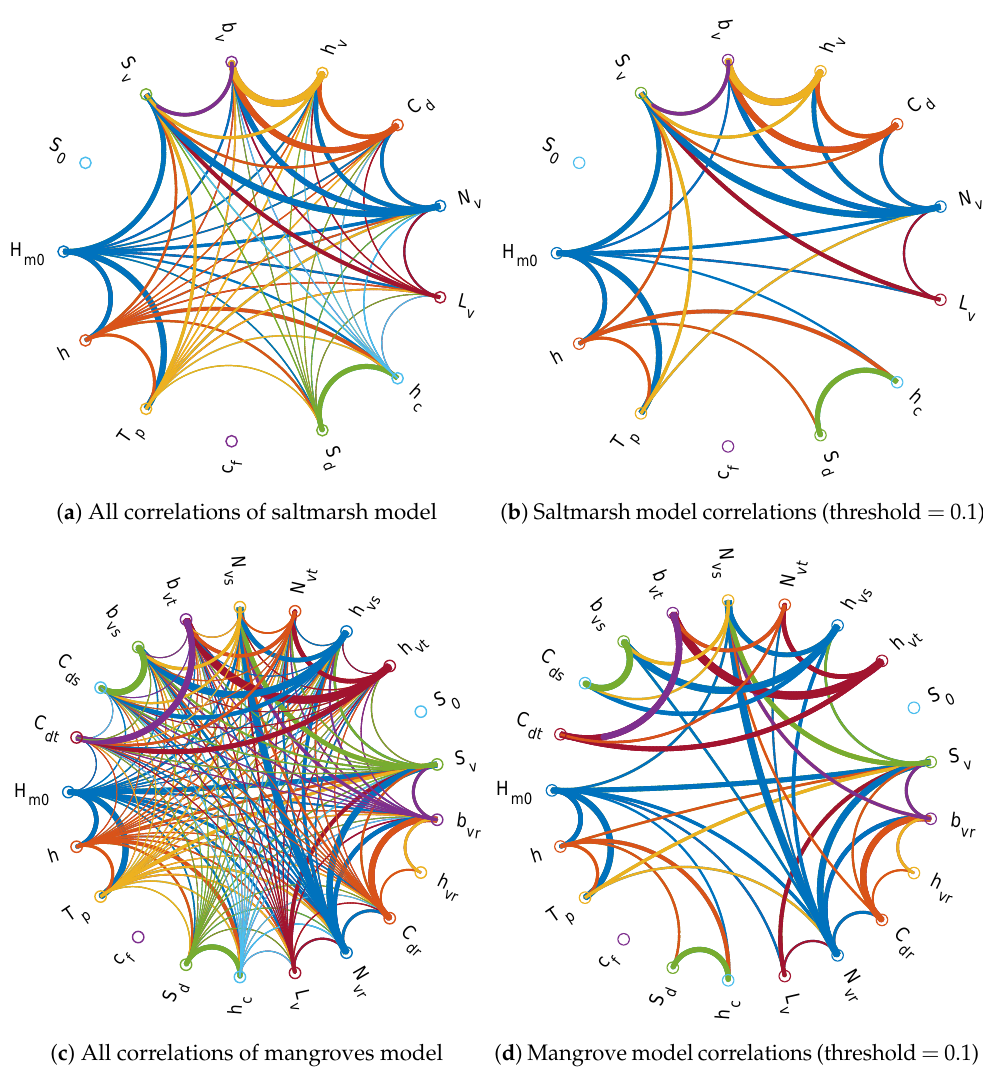
Figure 10. Correlations in global vegetated hydrodynamic conditions in saltmarshes ( a , b ) and mangroves ( c , d ). The circles represent nodes (variables), lines represent the correlations in the network, and thickness of the lines represents strength of the correlation. Plots ( b ) and ( d ) have minimum correlation threshold of 0.1 to distinguish dominant